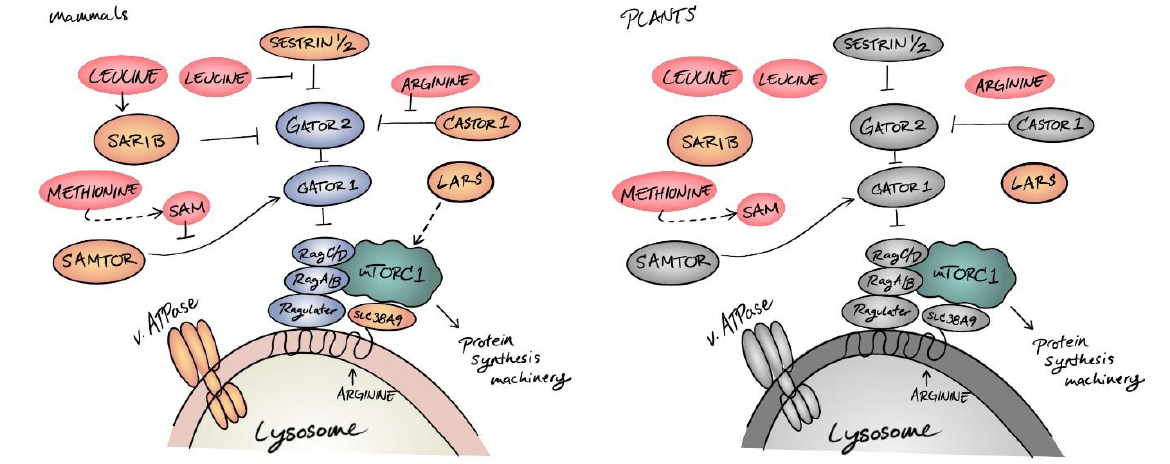
Figure 2. Amino acid signaling in eukaryotes. In mammals, amino acids (red) are monitored by multiple sensors (orange) that engage transducers (blue) at multiple steps in the GATOR2–GATOR1–Ragulator–Rag GTPase signaling cascade to coordinate TOR (teal) activity at the surface of the lysosome. Very few of these signaling components are conserved in plants (gray indicates not conserved in plants). Sar1b and LARS, which have essential roles in membrane trafficking and tRNA synthesis, respectively, were exapted as amino acid sensors in the animal lineage and may not act as amino acid sensors in plants.